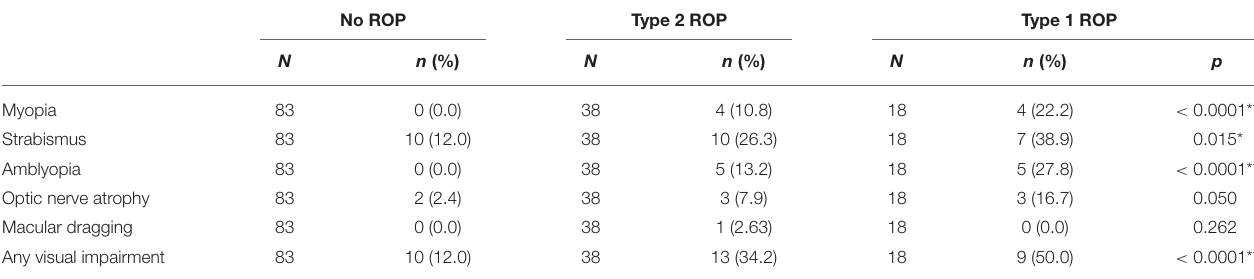
TABLE 2 | Summary of visual impairment in 139 participants seen for eye examination at the University of California, Los Angeles.